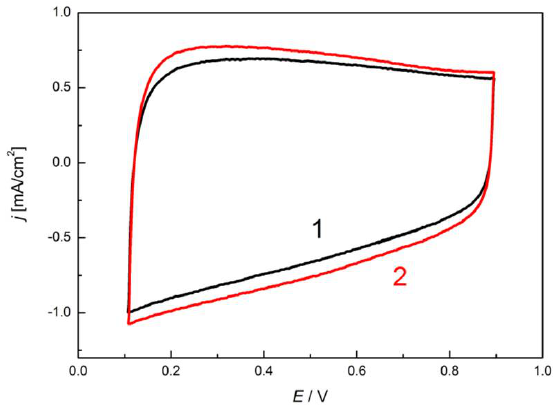
Figure 10. Cyclic voltammogram of a freshly prepared electrode in 0.1 M KOH (1), and after 500 cycles between potential limits 0.1 and 0.9 V